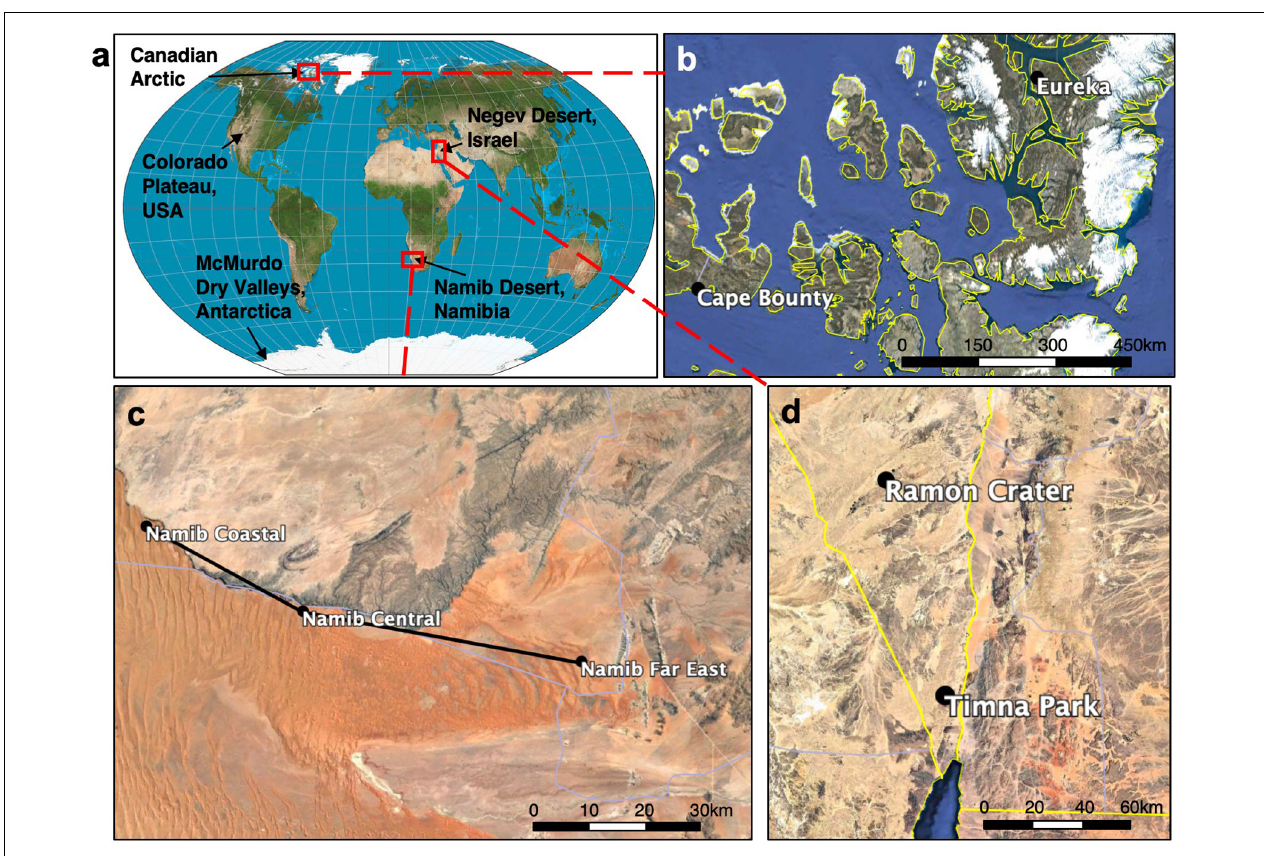
FIGURE 1 | Map of global and regional sandstone sampling sites. (a) World map showing sampling locations. In the Canadian Arctic (b) , Namib Desert (c) , and Negev Desert (d) samples were taken from multiple sites whose names and locations are shown. More detailed information can be found in